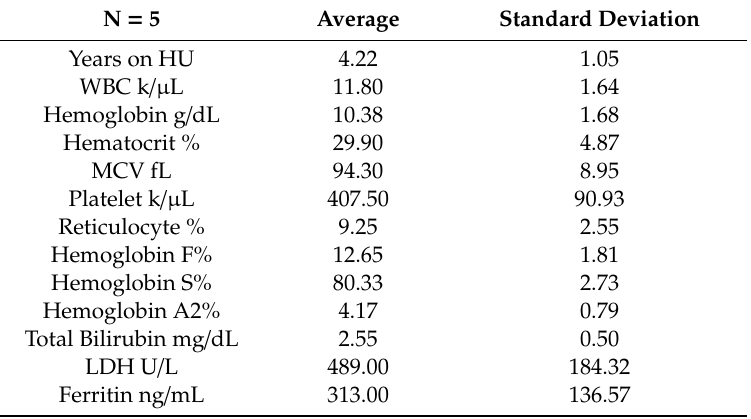
Table 2. Clinical laboratory values for BM samples, on